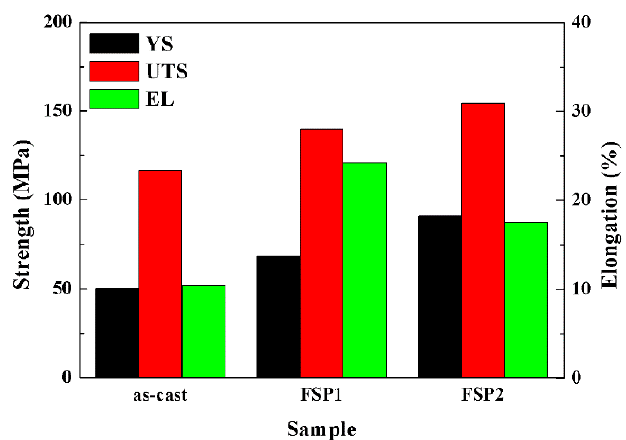
Figure 7. Mechanical properties of as-cast and Mg-6Sn samples created using FSP.